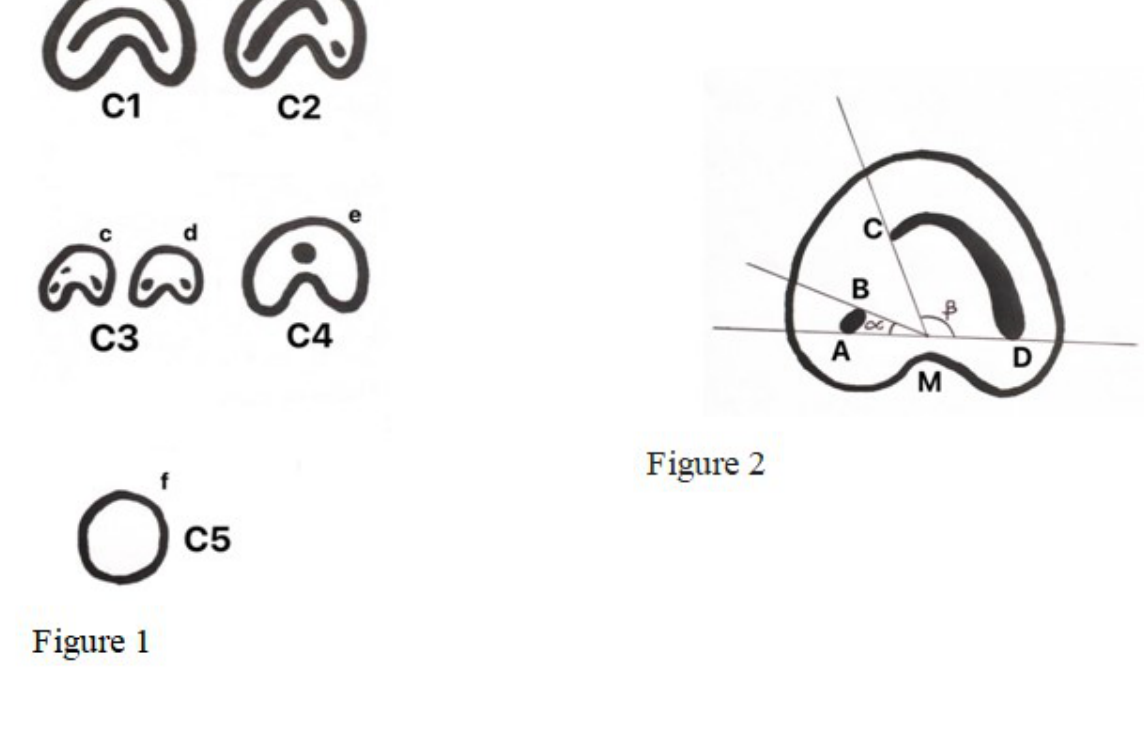
Fig. 1 - Classifica�on of C - shaped canal configura�on by Fan et al. [35]. Diagrams drawn according to the paper by Fan et al. [35].